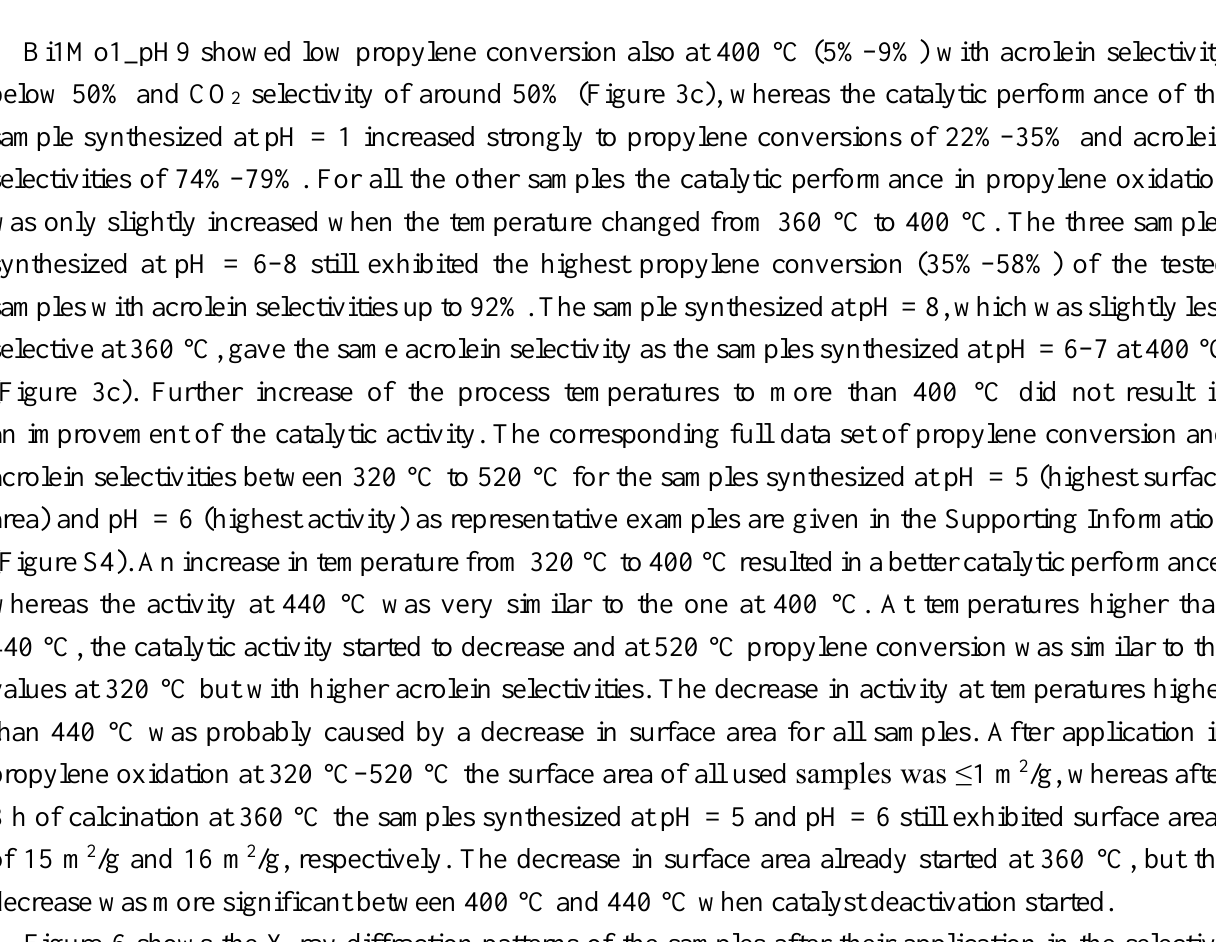
Figure 5. Comparison of the catalytic performance of the samples prepared at pH = 4 and pH = 9 with Bi/Mo = 1/1 and 2/3 and a reference sample synthesized by co-precipitation with Bi/Mo = 2/1 at 320 °C ( a ) and 360 °C ( b ). Reaction conditions: 500 mg catalyst; C 3 H 6 /O 2 /N 2 = 5/25/70; 50, 80 and 120